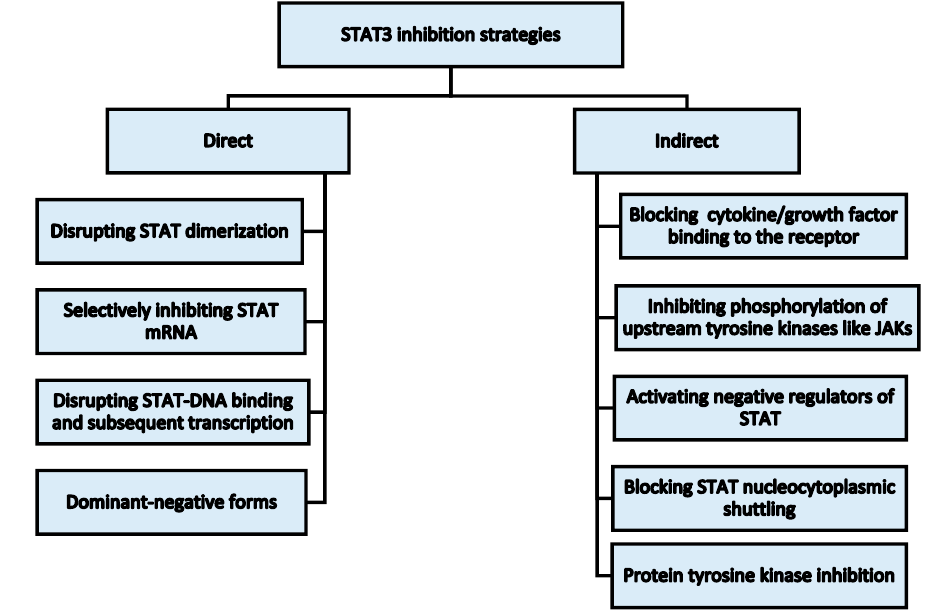
Figure 3. Various potential strategies for STAT3 inhibition.